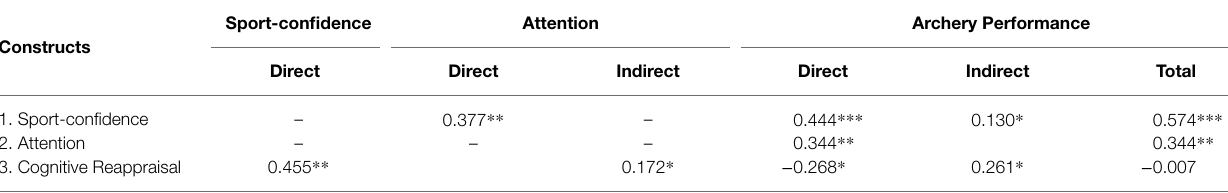
TABLE 6 | Direct effects and indirect effects of independent constructs among Archery performance.